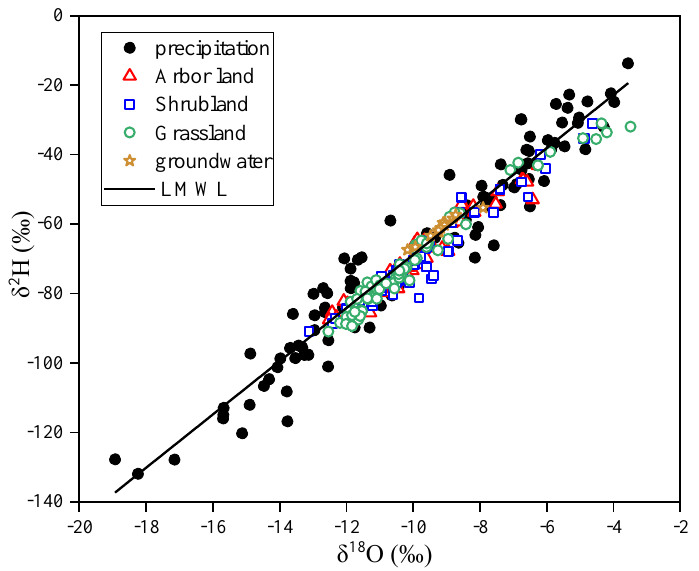
Figure 5. The relationship between δ 2 H and δ 18 O in precipitation, soil water, and groundwater.